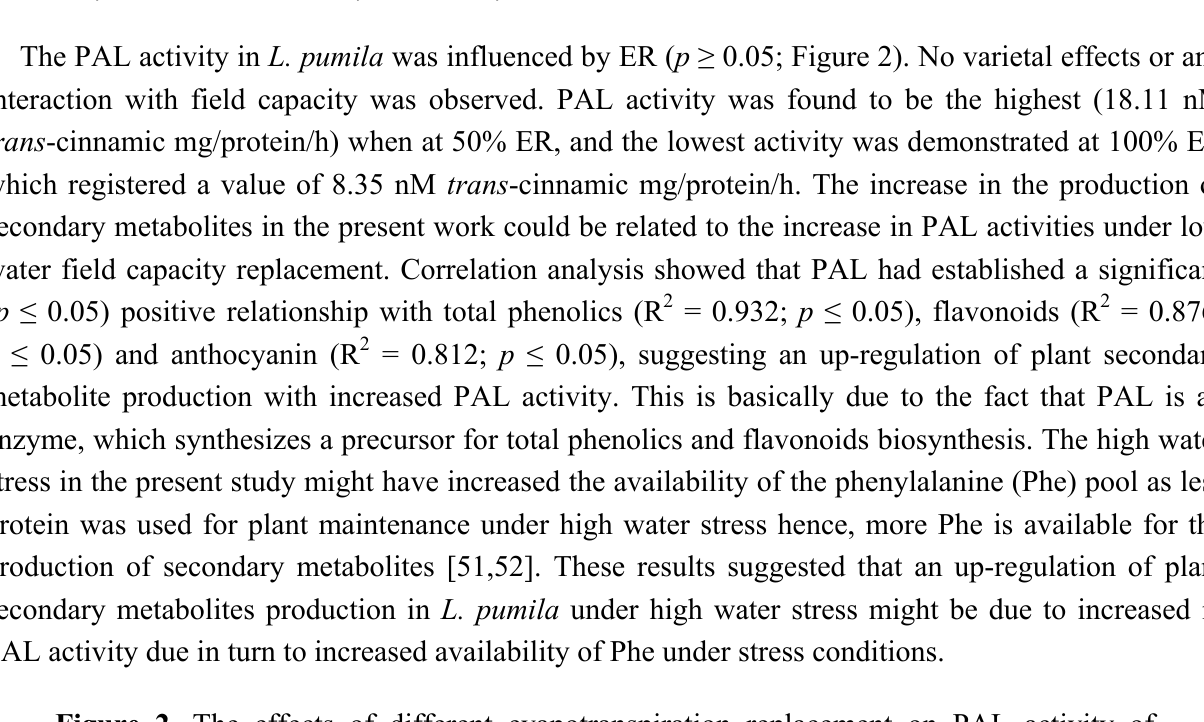
Figure 2. The effects of different evapotranspiration replacement on PAL activity of L.pumila . N = 60. Bars represent standard error of differences between means